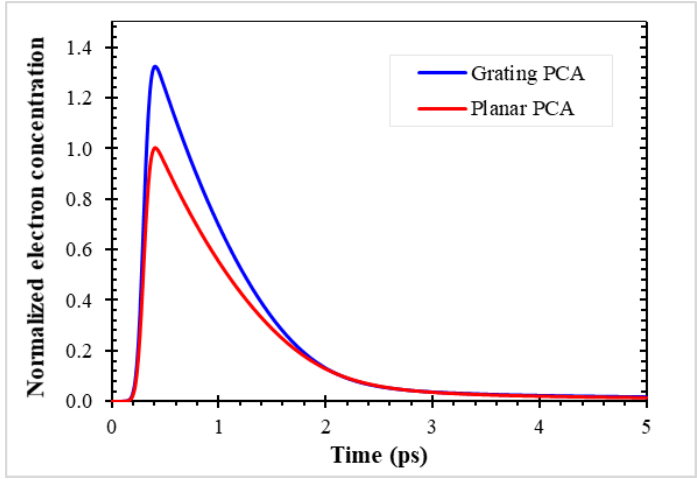
Figure 5. The temporal behavior of the normalized total number of electron carrier observed in the grating PCA (blue) and planar PCA (red).